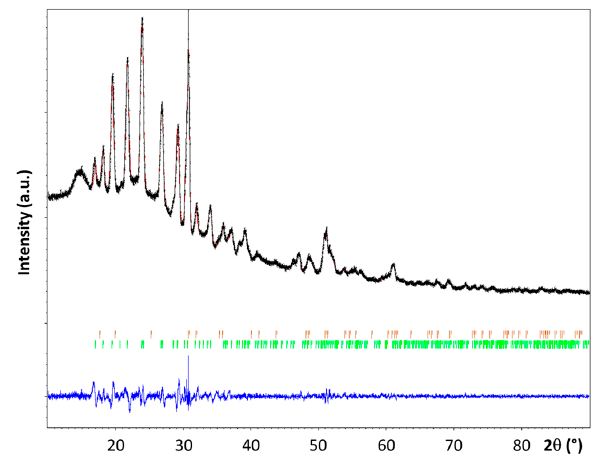
Figure 3. Observed (in black) and calculated (in red) powder X-ray diffraction profiles for the Rietveld refinement of the LiN 2 H 3 BH 3 · x NH 3 phase. The bottom curve (in blue) is the difference plot on the same scale intensity and the tick marks (in green for LiN 2 H 3 BH 3 · x NH 3 and in orange for LiNH 2 ) are the calculated angles for the Bragg peaks in 2 θ ( λ = 1.5418 Å).